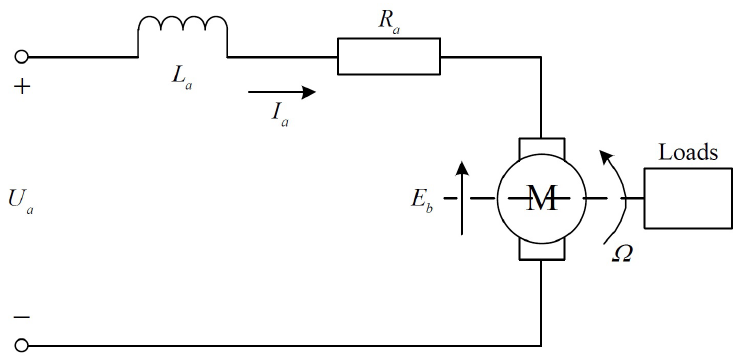
Figure 2. Equivalent circuit diagram.